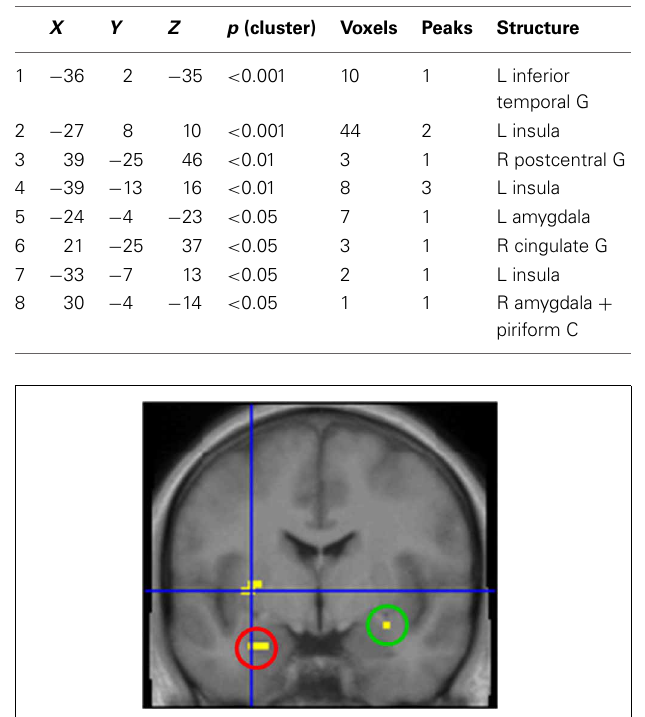
Table 2 | Brain activations following odor stimulation in all subjects;